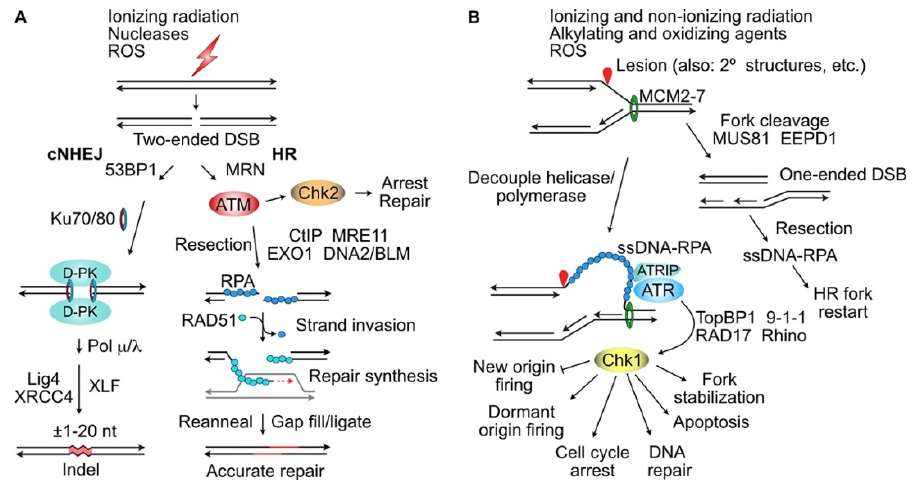
Figure 1. DNA-PK, ATM and ATR roles DSB repair by cNHEJ, HR, and replication fork restart. ( A ) Two-ended (frank) DSBs are shunted to cNHEJ if resection is blocked by 53BP1 (and RIF1), or to HR when resection is promoted by MRN and signaling through ATM. Ku70/80 binds unresected ends and recruits DNA-PKcs (D-PK) which tethers ends, and promotes end alignment, template-dependent and -independent nucleotide addition by Pol λ and Pol µ , respectively, and ligation by Lig4-XRCC4 and XLF to yield indel repair products. ATM phosphorylates/activates Chk2 which promotes cell cycle arrest and repair. ATM stimulates DSB repair by HR by phosphorylating targets that promote limited end resection by CtIP and MRE11, and extensive resection by EXO1 and DNA2-BLM. The resulting 3 ′ ssDNA extensions are bound by RPA, which is replaced by the HR recombinase RAD51 that catalyzes invasion of homologous duplexes (typically sister chromatids). Eviction of RAD51 allows repair synthesis to extend the invading strand across the DSB. The extended end releases from the donor duplex (grey) and anneals to complementary ssDNA on the opposite side of the DSB. Gap filling and ligation complete accurate HR repair. ( B ) Replication forks blocked by single-strand lesions or secondary structures, or stalled by nucleotide depletion or DNA polymerase inhibitors, causes decoupling of polymerase from the MCM helicase, which spools out ssDNA that is bound by RPA. ATRIP mediates the interaction between ssDNA-RPA and ATR, which leads to Chk1 activation that phosphorylates targets that effect several DNA damage checkpoint responses. Blocked or stalled forks may be cleaved by nucleases MUS81 or EEPD1 to yield one-ended DSBs that are resected to promote HR-mediated fork restart and prevent genome rearrangements due to cNHEJ rejoining of one-ended DSBs to ends of other DSBs.